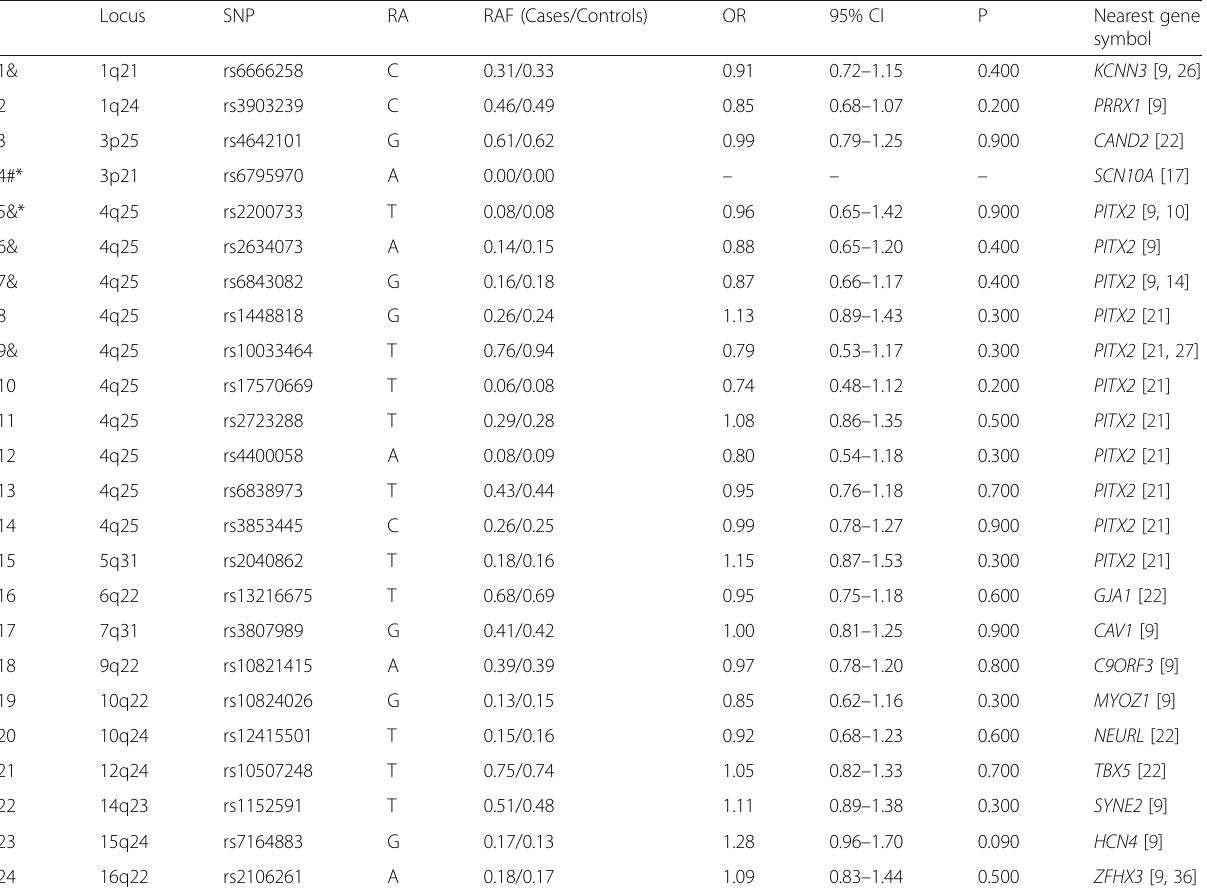
Table 2 Additive genetic model of inheritance (per copy allele frequency) for association of 24 SNPs previously associated with atrial fibrillation, and in this study investigated for association with ventricular fibrillation before ST-segment elevation myocardial